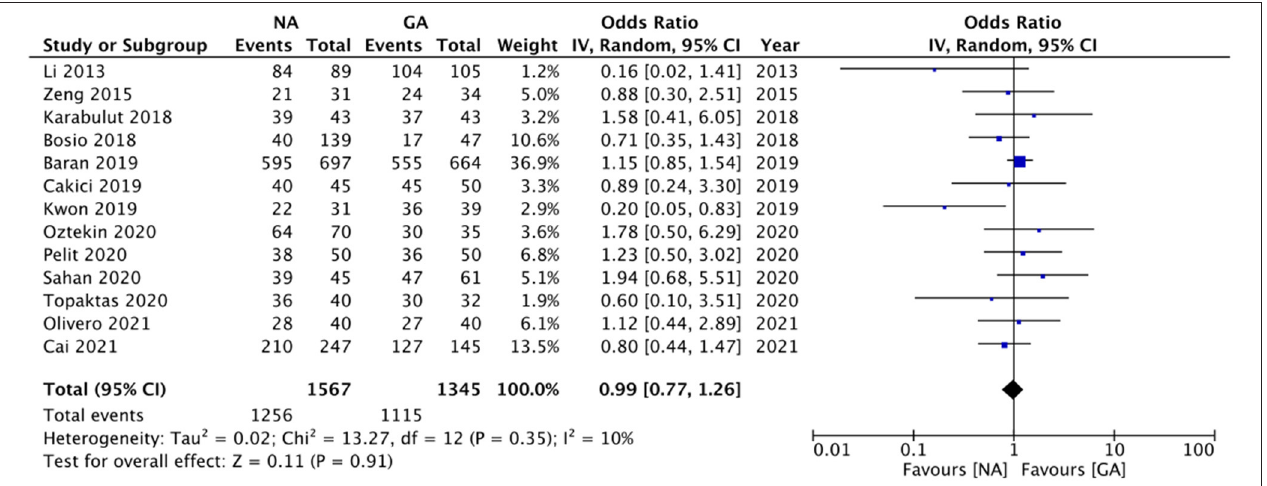
FIGURE 2 | Meta-analysis of stone free rates between NA and GA for